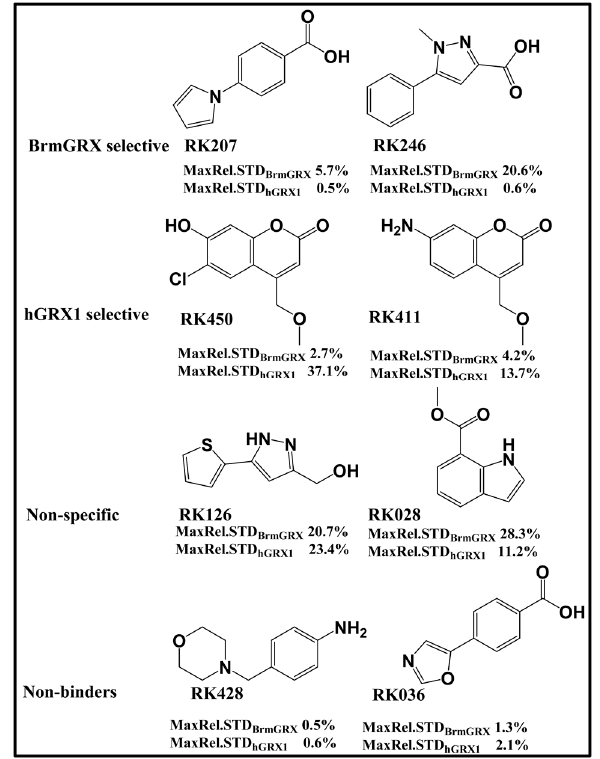
Figure 1. Representative fragments showing different sets of binders.